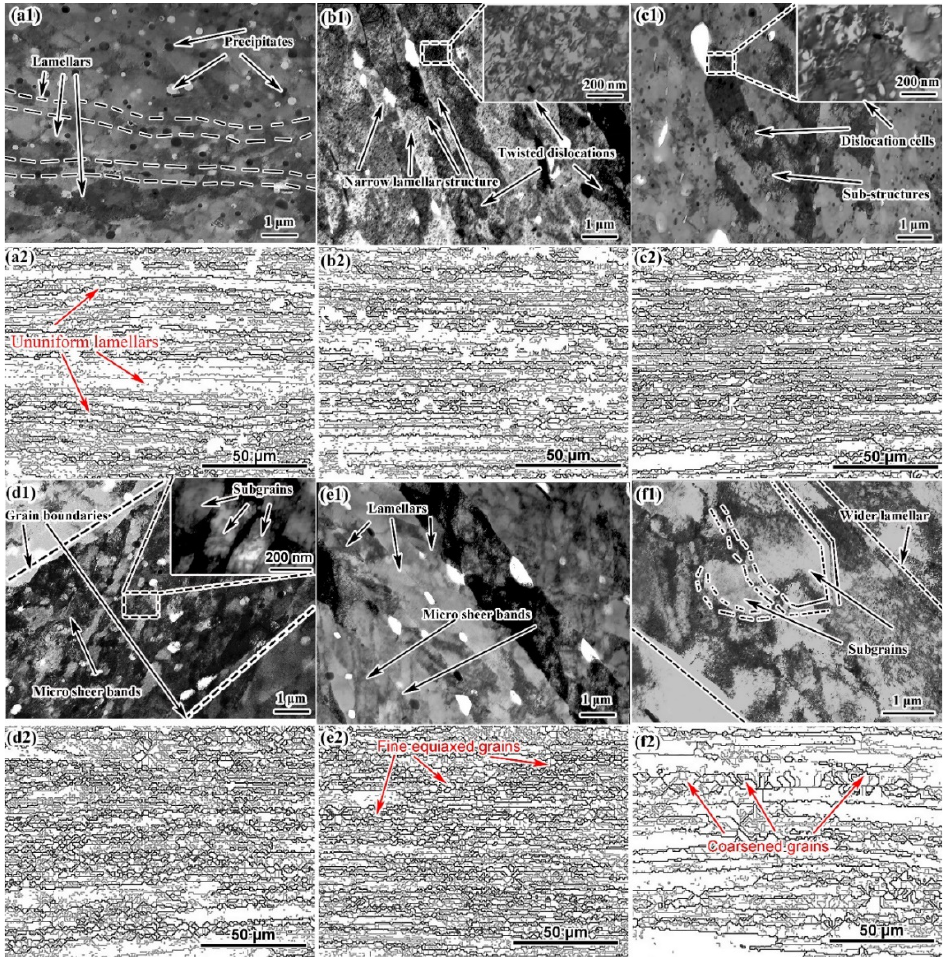
Figure 7. TEM (( a1–f1 ) with the enlarged inserted images of the labeled areas) and EBSD (( a2–f2 ) with black HAGBs and gray LAGBs) of 7055 Al alloys after the final hot deformation: ( a1,a2 ) for CRTMT; ( b1,b2 ) for DRTMT 1 ; ( c1,c2 ) for DRTMT 2 ; ( d1,d2 ) for DRTMT 3 ; ( e1,e2 ) for DRTMT 4 ; ( f1,f2 ) for DRTMT 5.